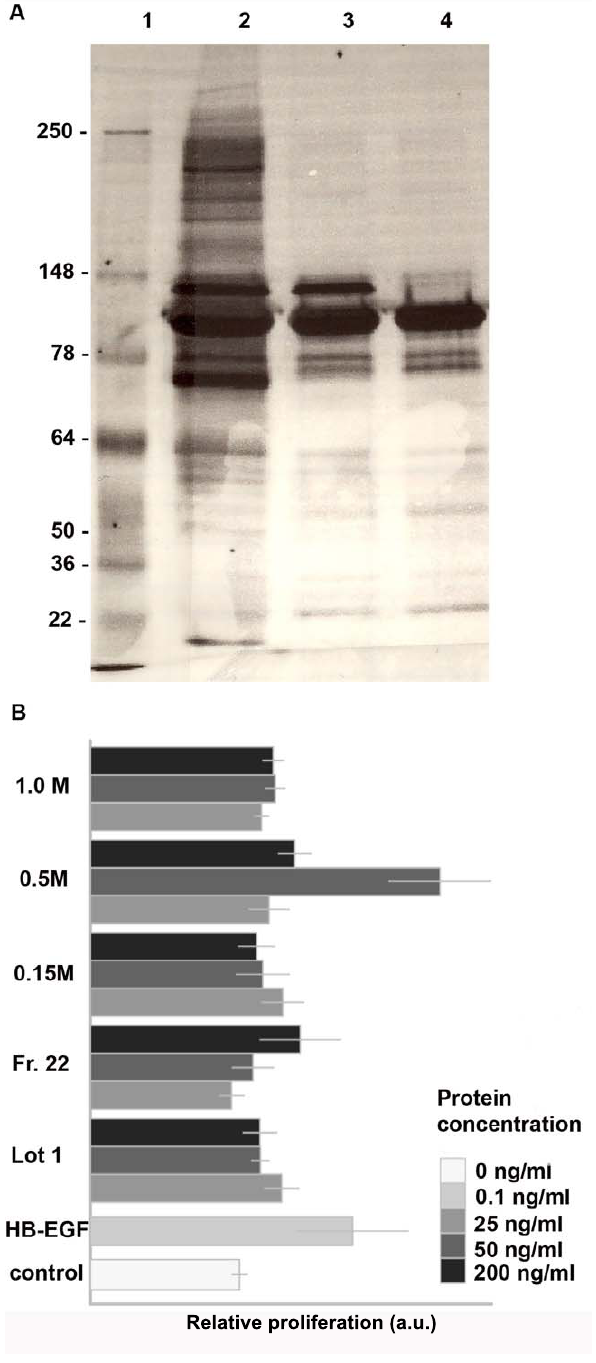
Figure 3. Characterization of Lot 1-derived fractions. A – silver stained SDS-PAGE demonstrating reduction of composition complexity following gel filtration and ion exchange chromatography. 1 - MW markers, 2 – unfractionated lot 1, 3- fraction 22, 4 – proteins eluted with 0.5 M NaCl. B – fractionated platelet extracts retain their biological activity toward epithelial cells. For proliferation assay NeoNHEK were plated in keratinocyte growth medium the presence or absence of unfractionated proteins from Lot 1 or fractions of Lot 1 (0.1–200 ng/mL) as indicated. HB-EGH (10 ng/mL) was used as positive control. Relative proliferation compared to control is shown. Data are presented as mean + / 2 standard error.